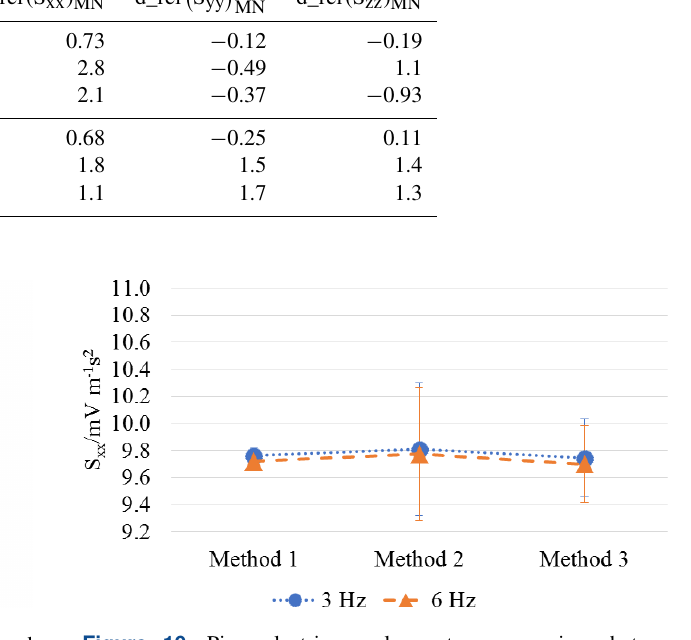
Figure 8. Piezo-electric accelerometer: sensitivity matrix obtained by means of Method 2 (3-D diagram).